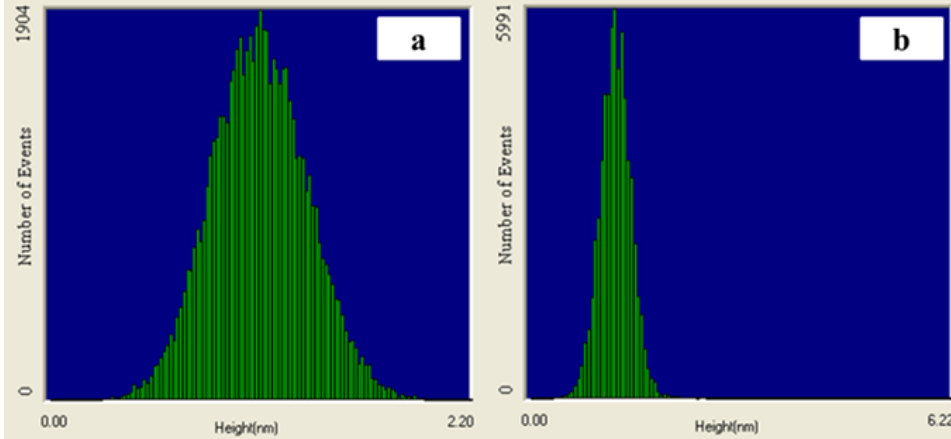
Figure 3. The height distribution of ( a ) diphenylacridine (SP1) and ( b ) phenothiazine (SP2).